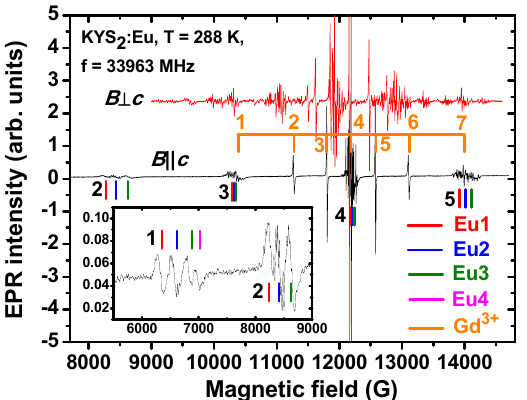
Figure 12. EPR spectra measured in KYS 2 :Eu single crystal at two magnetic field directions B || c and B K c . The numbers are assigned to particular transitions similar to Figure 10. Inset demonstrates the low field edge of the spectrum where the line segments indicate the transitions produced by four Eu 2+ centers of almost equal intensity. They are designated as Eu1, Eu2, Eu3 and Eu4.